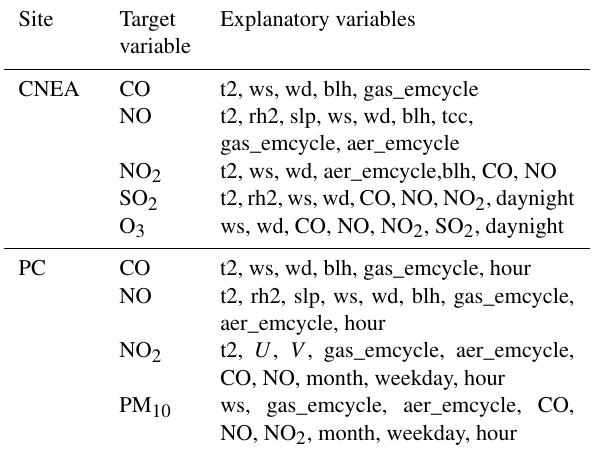
Table 3. Random forest model with the target variables, predictors, and hyperparameters for